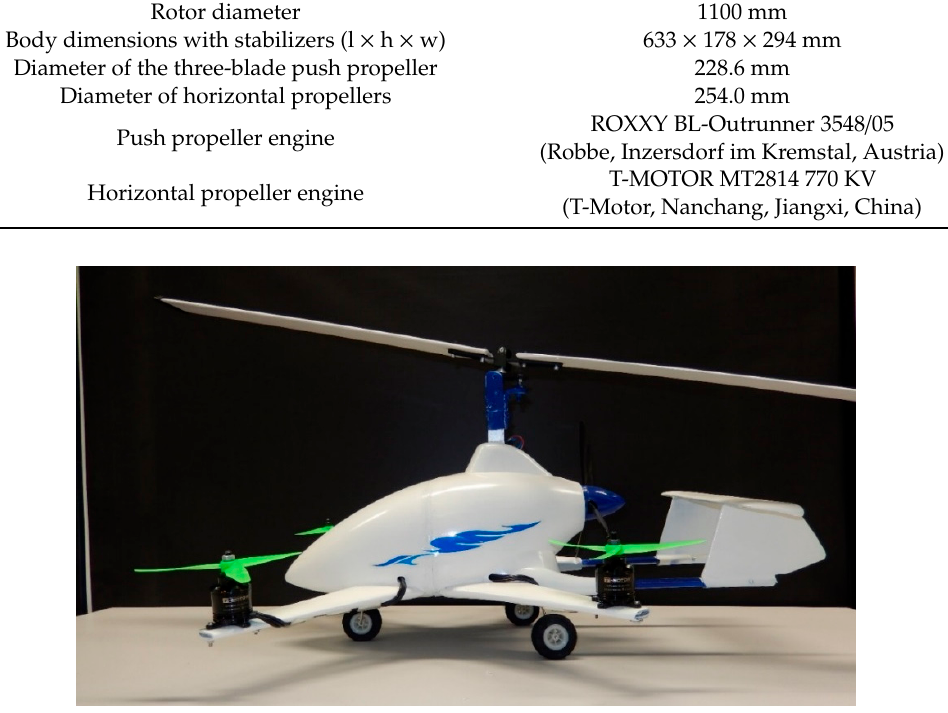
Figure 4. Taifun gyroplane-geometrical dimensions (mm) of the object (view from the left). The drive unit of the examined object consisted of several cooperating key elements, i.e., propellers, engines, control regulators, power supply (battery), flight controller, and radio-controlled (R/C) devices. A set of propellers and engines were responsible for generating thrust. Blades with the NACA-9H-12 profile were used. Each set generated about 1800 g of thrust from each engine. This value was required to lift the aircraft, including sufficient reserves to perform maneuvers during the